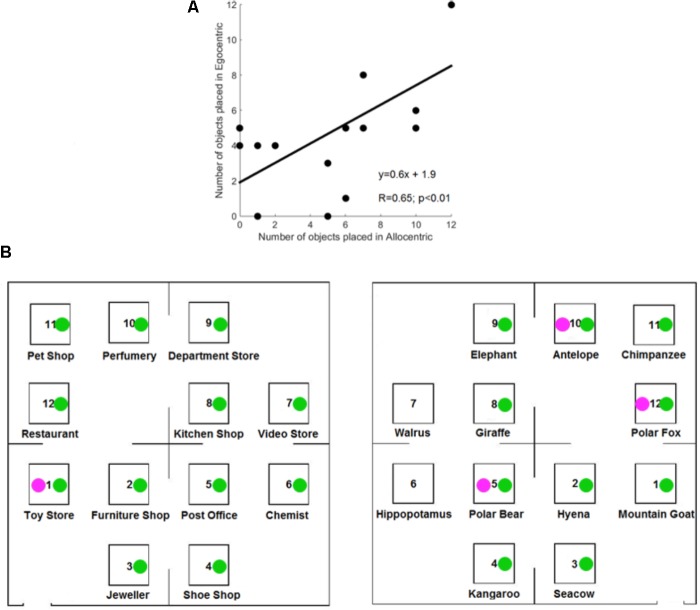
Results of the free-recall task in controls participants. (A) Correlation between the number of objects correctly placed in Allocentric and Egocentric conditions for the control participants. (B) Correctly located objects of GL (in magenta) and IW (in green).